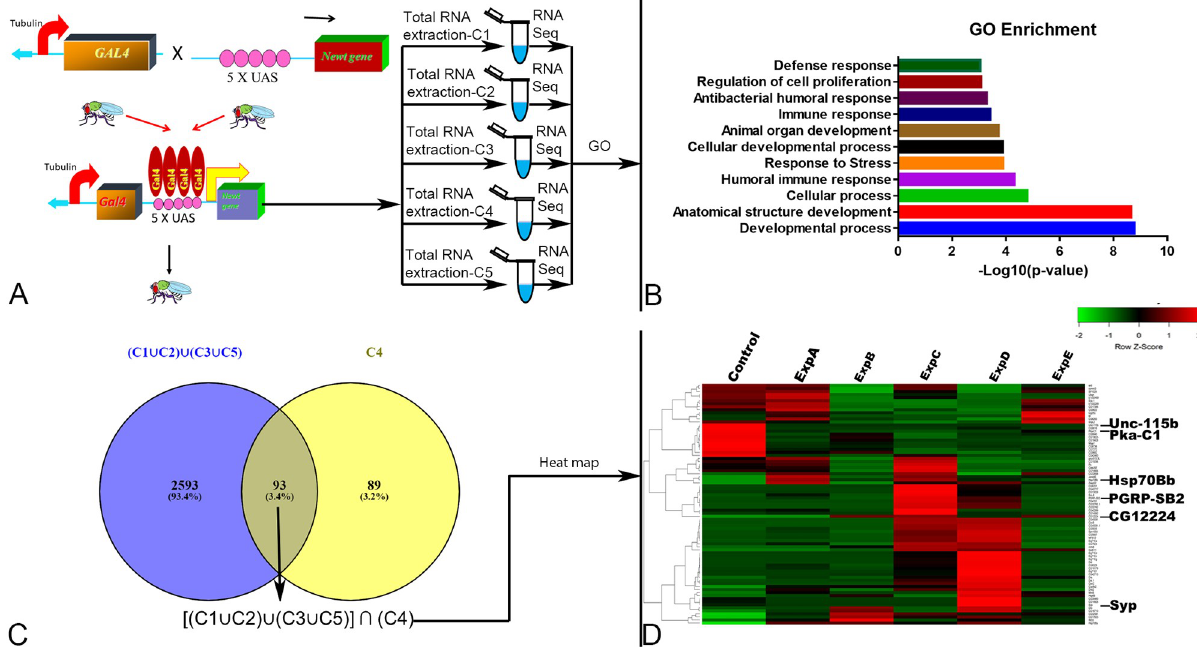
Fig 3. Targeted misexpression of newly identified Newt gene family in Drosophila using Gal4/UAS binary system followed by next generation RNA sequencing. (A) Schematic representation of misexpressing Newt genes ubiquitously in Drosophila using Tubulin driver. It was followed by collection of sample for RNA sequencing at 3 rd instar stage [29]. (B) Bar graph showing enriched gene ontology (GO) terms on the scale of–Log 10 (p- value). (C) Venn diagram showing 93 selected genes (D) Heat map constructed (for 93 common transcripts) from the expression profiles of the 6 sequenced samples. Control: Tubulin Gal4/S-T, Exp A: Candidate 1/Control, ExpB: Candidate 2/Control, ExpC: Candidate 3/Control, ExpD: Candidate 4/Control, ExpE: Candidate 5/Control respectively. Heat map was divided into cluster A: showing genes upregulated by misexpression of C4, and Cluster B: showing genes downregulated by misexpression of C4. The location of the genes used for RT- qPCR analysis is shown on the heat map.